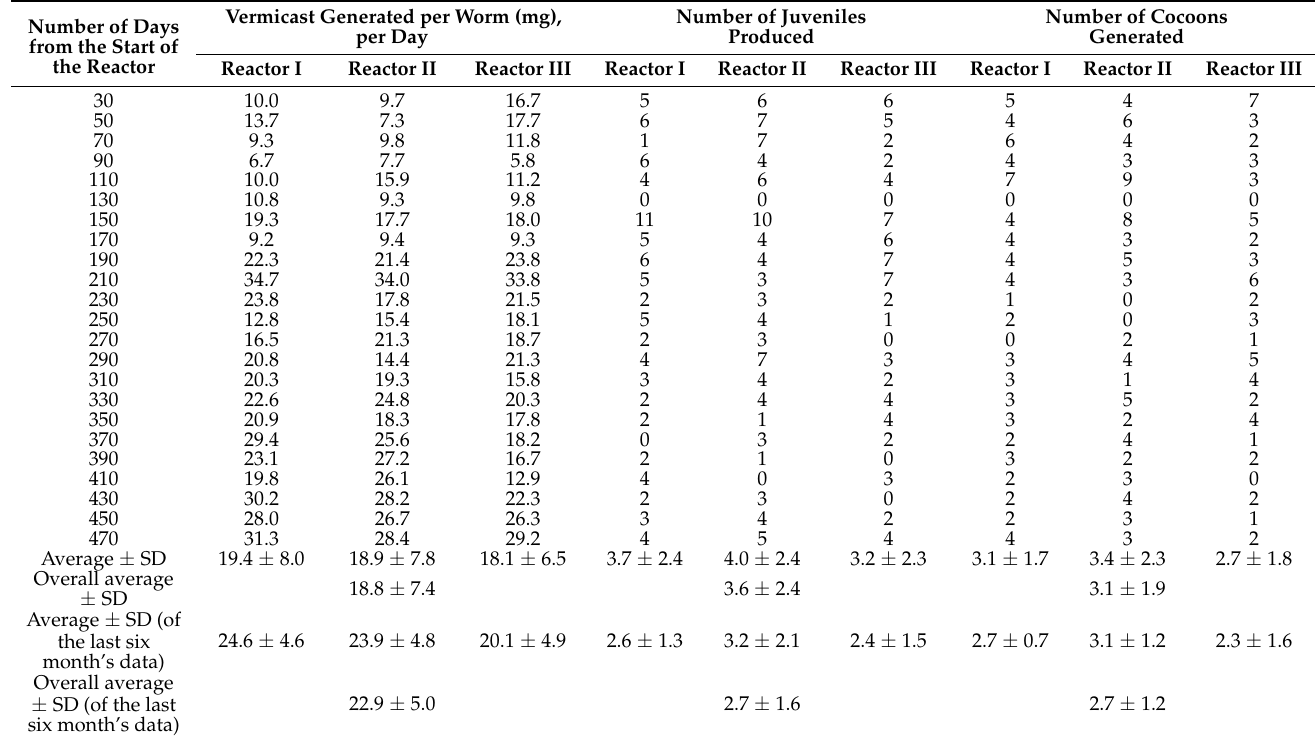
Table 7. Vermicomposting of parthenium with 50 adults of E. fetida per kg of feed in pulse-fed modules.